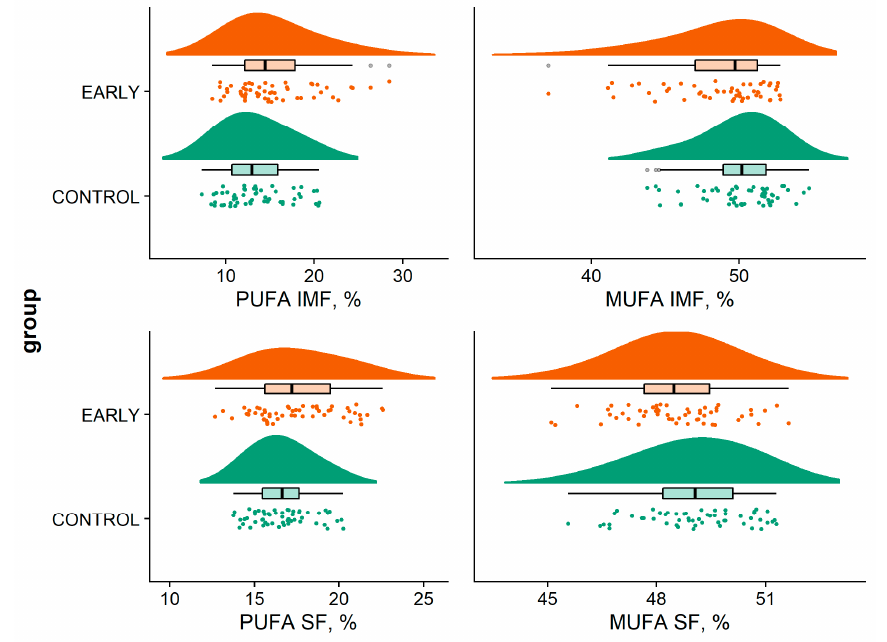
Figure 2. Fatty acid composition (sum of monounsaturated fatty acid (MUFA) and polyunsaturated fatty acid (PUFA), respectively) in subcutaneous fat (SF) and intramuscular fat (IMF) according to immunization scheme.